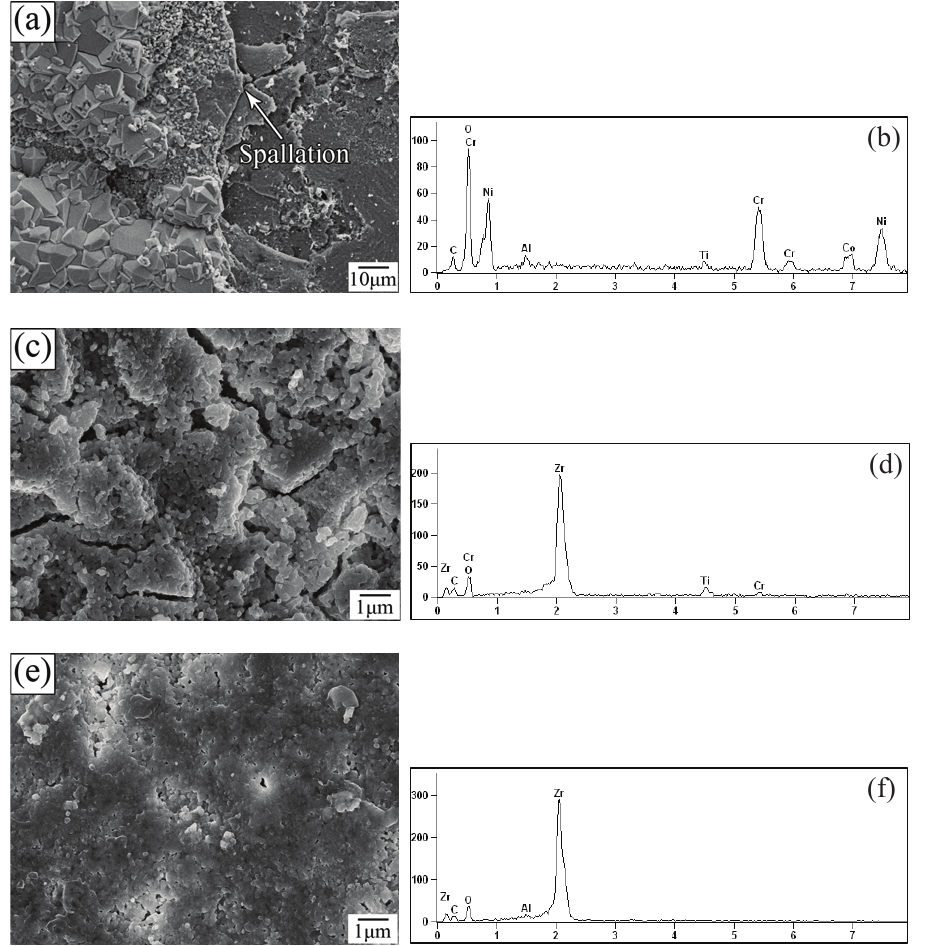
Figure 6. Surface morphologies and chemical compositions of specimens with various coatings after